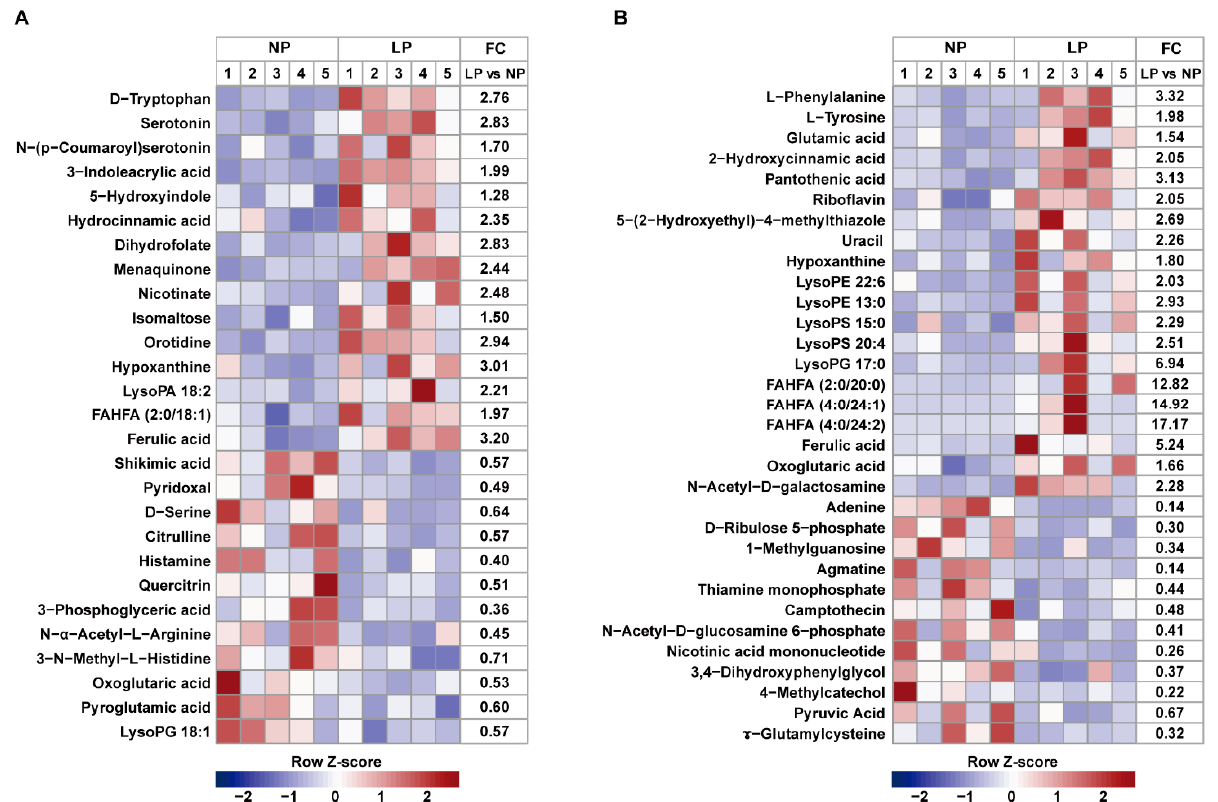
Figure 3. Effects of protein restriction and realimentation on colon metabolic profiles of piglets. Heatmap for the differentiated metabolites with VIP >1 and p < 0.05 and fold change (FC) ≥ 1.20 or ≤ 0.83 at day 14 ( A ) and the end of the experiment ( B ). Metabolites peak area were Z score transformed. Each sample is visualized in a single column and each metabolite is represented by a single row. The relative metabolite level is depicted according to the color scale. Red color indicates upregulation, and blue color indicates downregulation. NP, normal protein group. LP, low protein group.